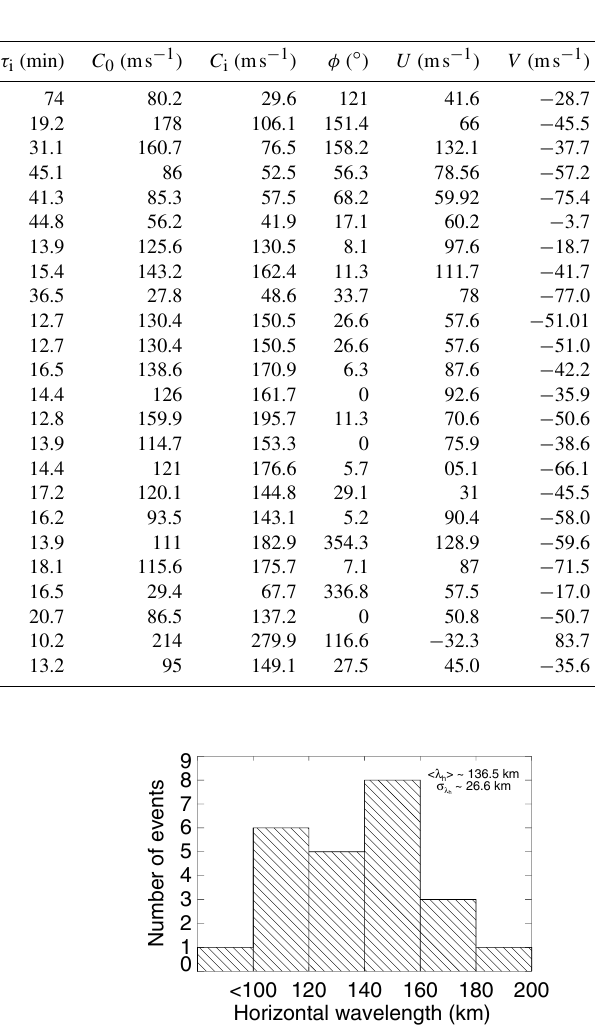
Table 1. Observed and intrinsic parameters of medium-scale gravity waves over São do João do Cariri. Intrinsic parameters are denoted by “i” and observed by “o”. The propagation direction is represented by φ and increases clockwise from the north. The horizontal components of the wind are represented by U and V for zonal and meridional components, respectively. The “Events” column represents the sequential order used in Figs. 4 and 5.